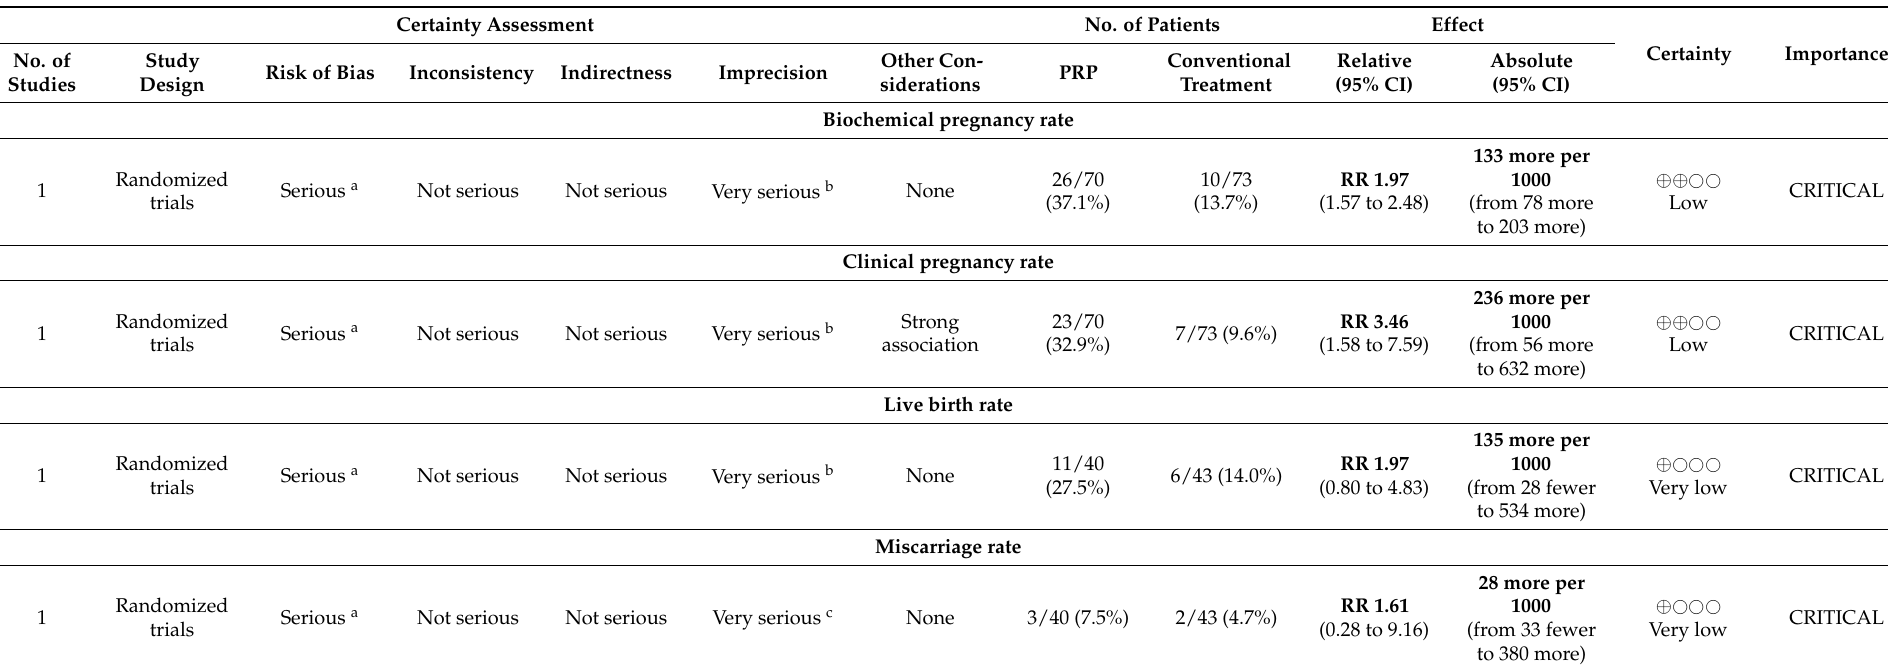
Table 4. Summary of the quality assessment by GRADE approach of outcomes included in the meta-analysis of thin endometrium